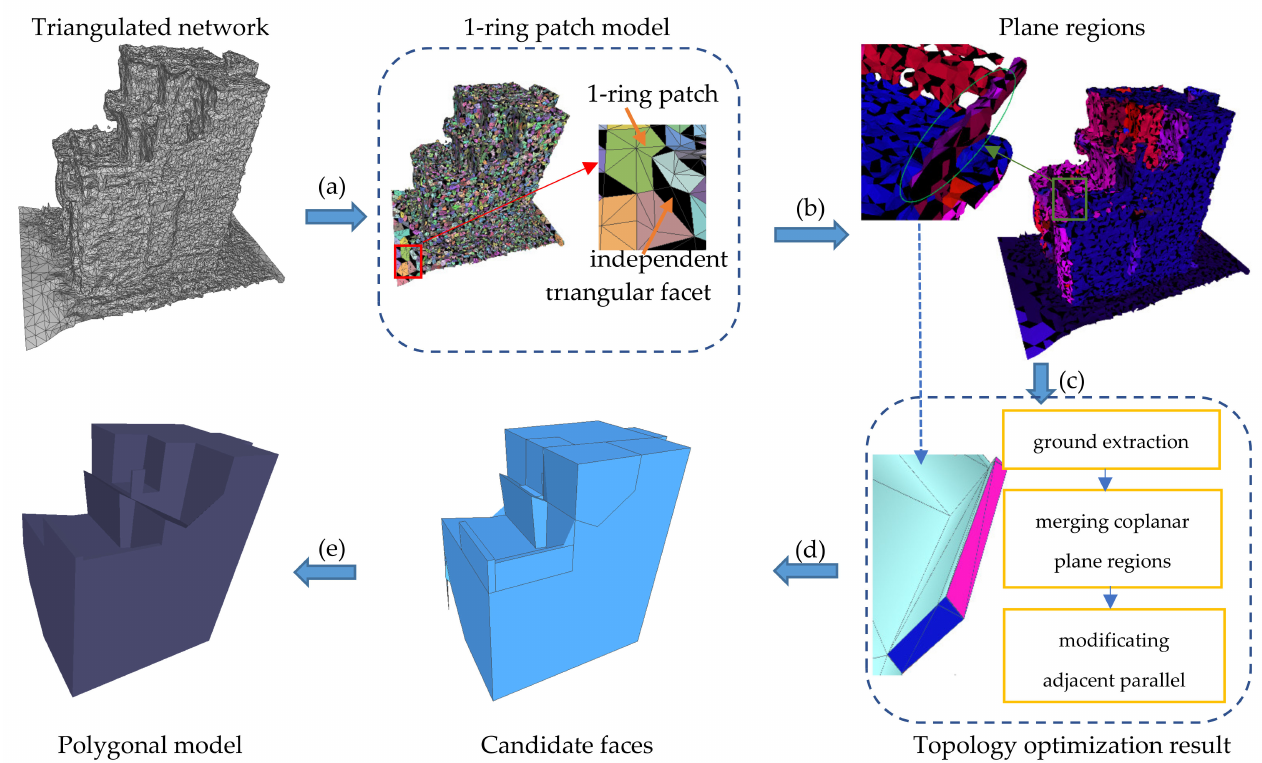
Figure 1. Pipeline. The parts connected by the dotted line show the restoration of a parapet via topology